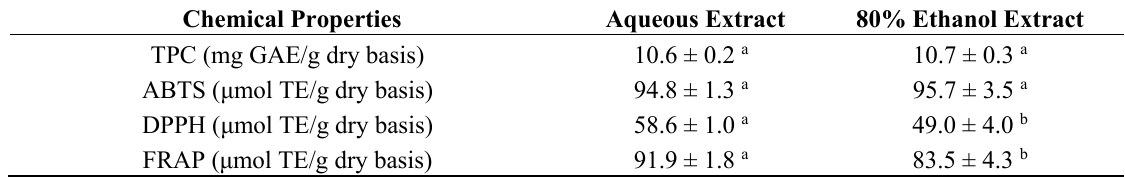
Table 1. The phenolic compound content (TPC) and the antioxidant capacity of the optimised aqueous extract of bitter melon compared with the 80% ethanol extract.